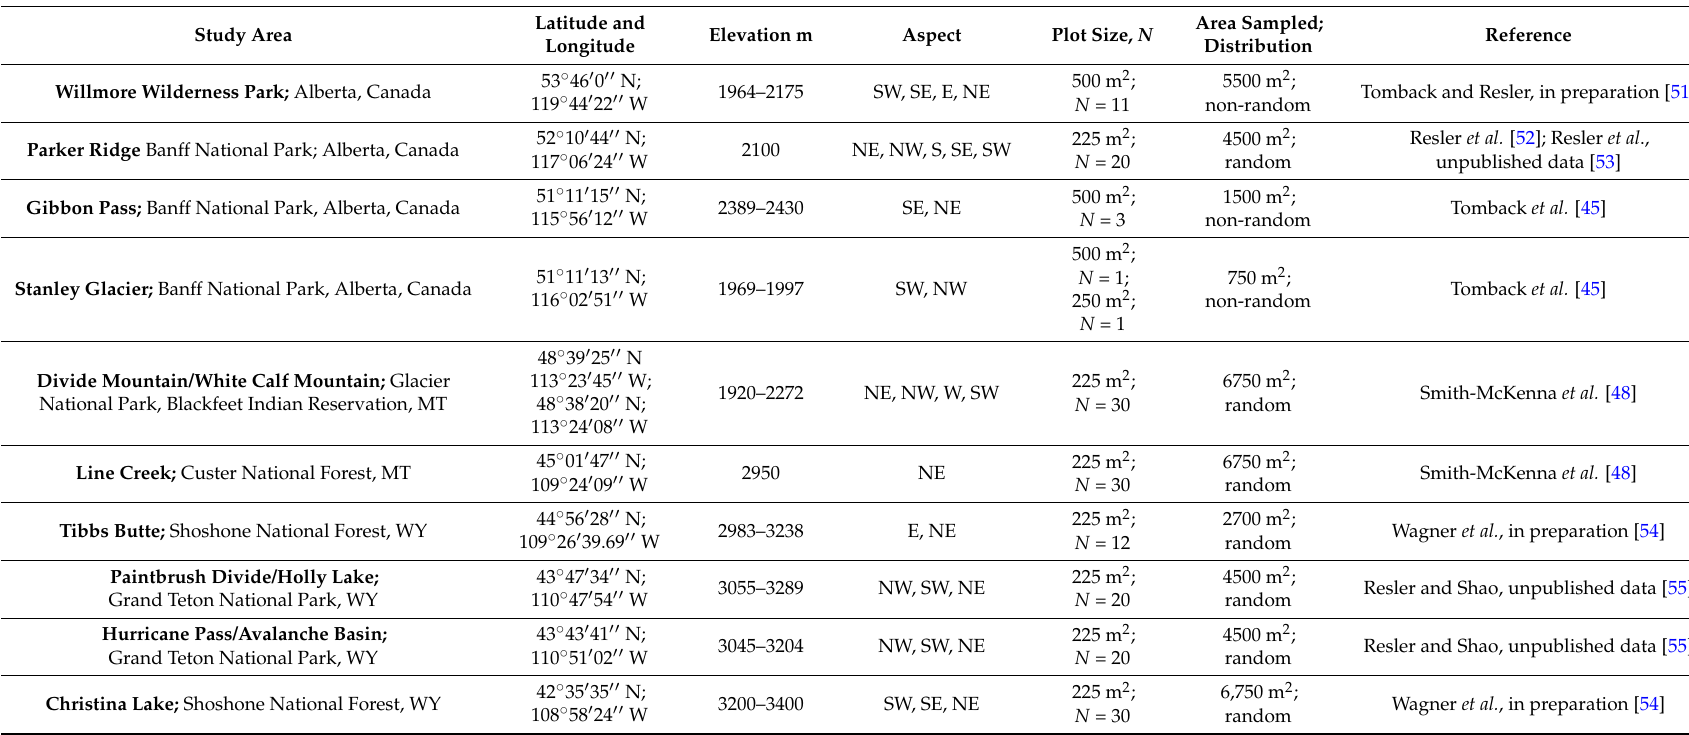
Table 2. Study areas across the latitudinal range of whitebark pine in the Rocky Mountains, and sampling methods providing information on structure and composition of treeline